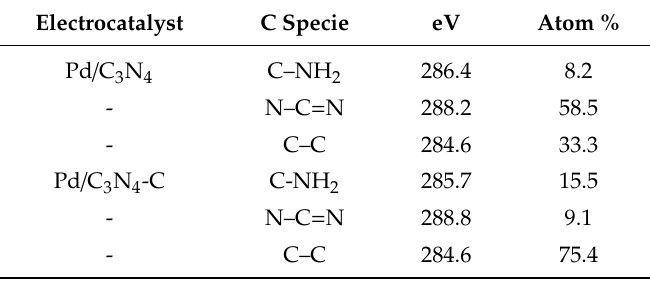
Table 2. Percentages of carbon species from spectra of C 1s.